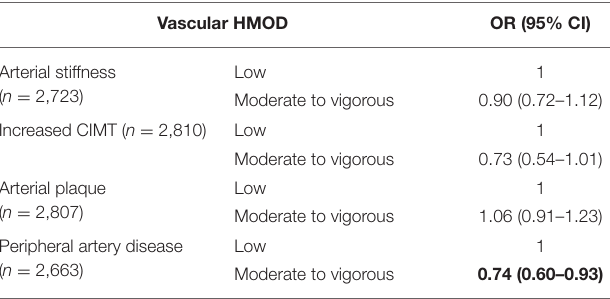
TABLE 4 | Risk of vascular HMOD across different levels of physical